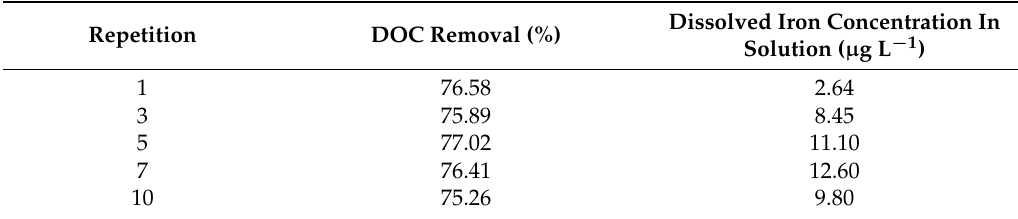
Table 6. Effect of catalyst stability on catalytic